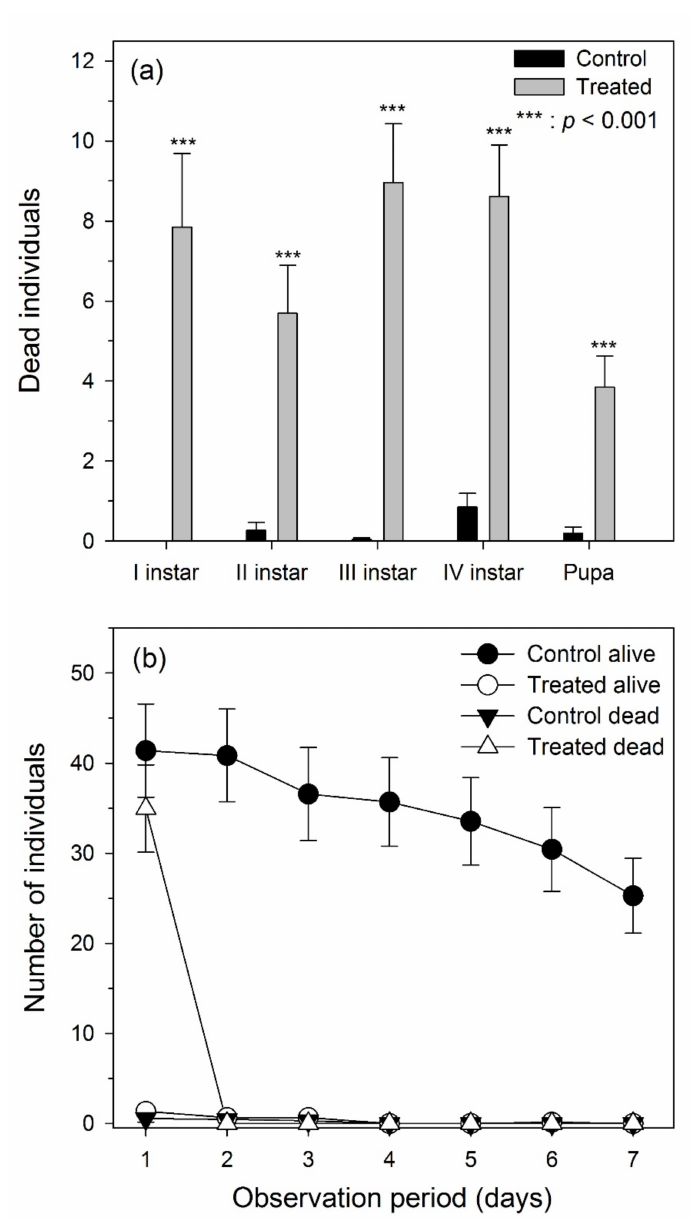
Figure 6. ( a ) Aedes aegypti larval mortality after of Larvasonic treatment. Asterisks indicate significant di ff erences between control and treatment mortalities (ANOVA, Tukey’s honestly significant di ff erence (HSD) test, p < 0.05). ( b ) Total mosquito larval mortality and survival after Larvasonic treatments. Data and statistical analysis consider the proportion of larvae / pupae killed or surviving and not absolute numbers that were